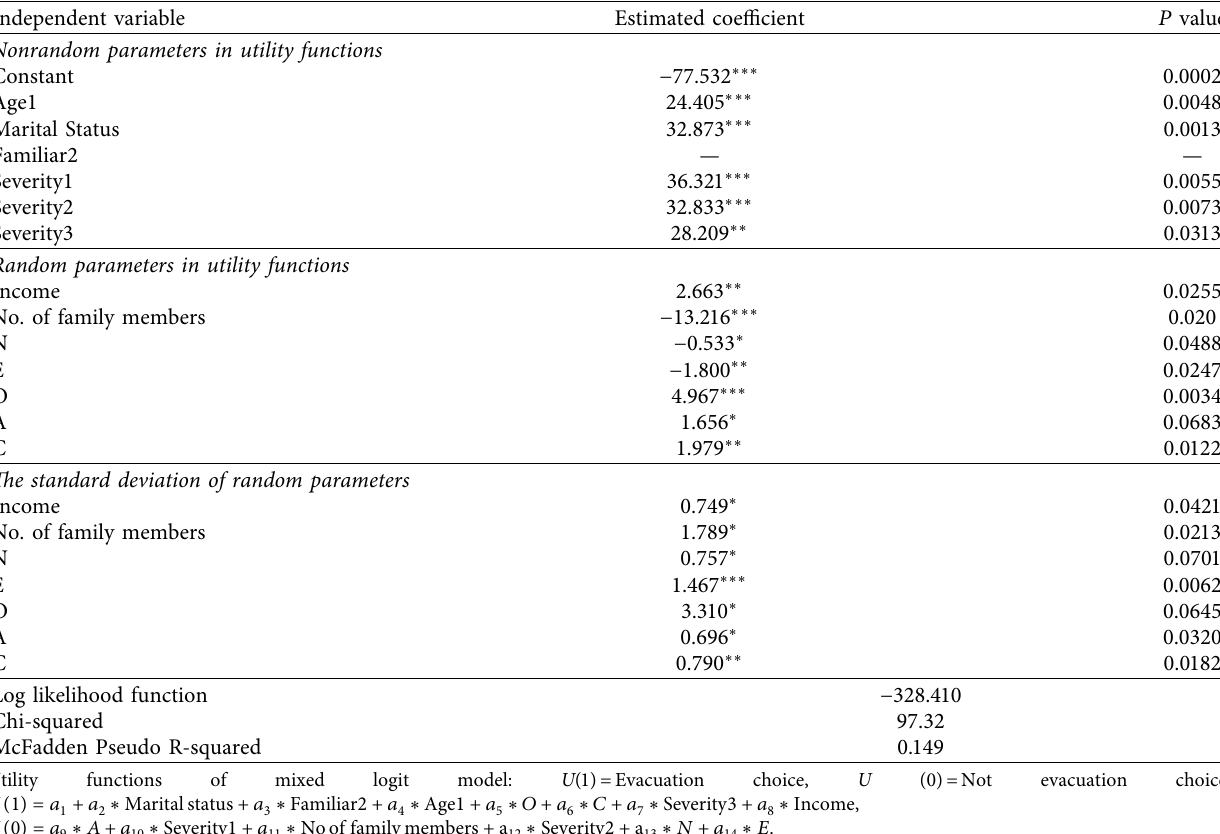
Table 8: The result of random parameters/mixed logit